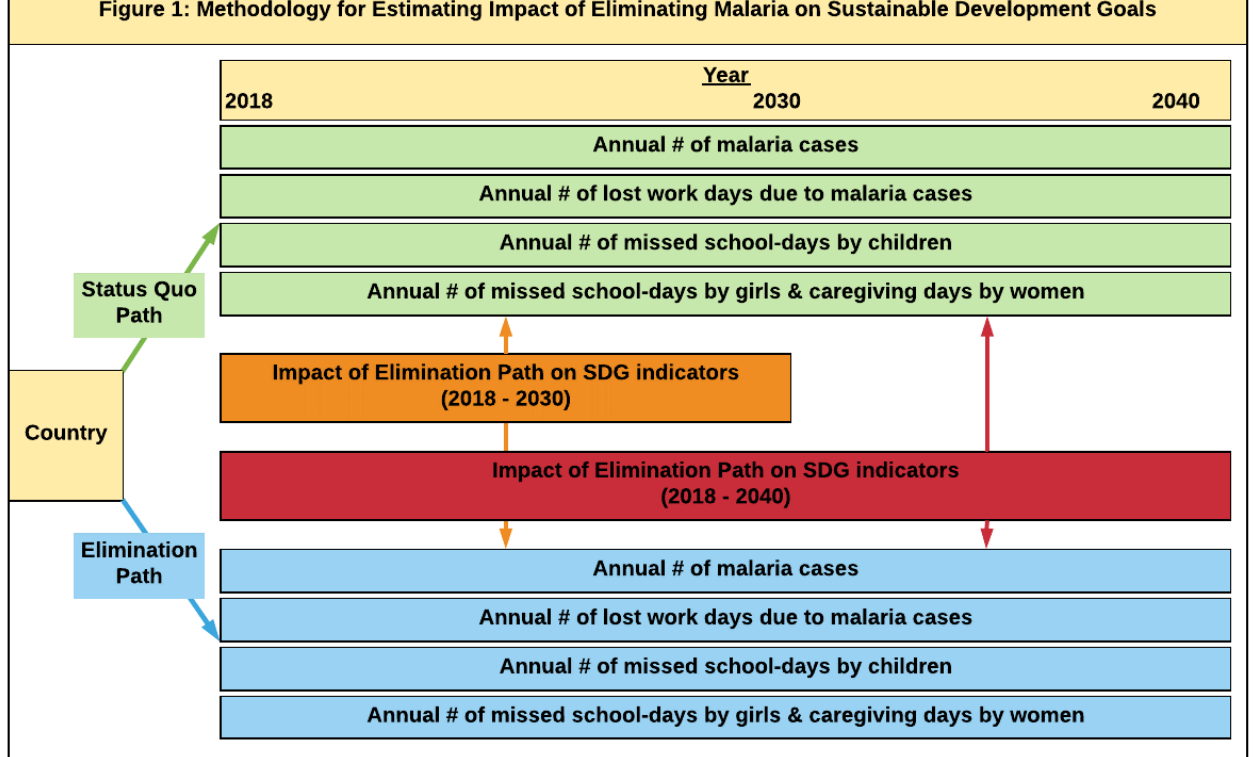
Figure 1. Methodology for estimating impact of eliminating malaria on Sustainable Development Goals.